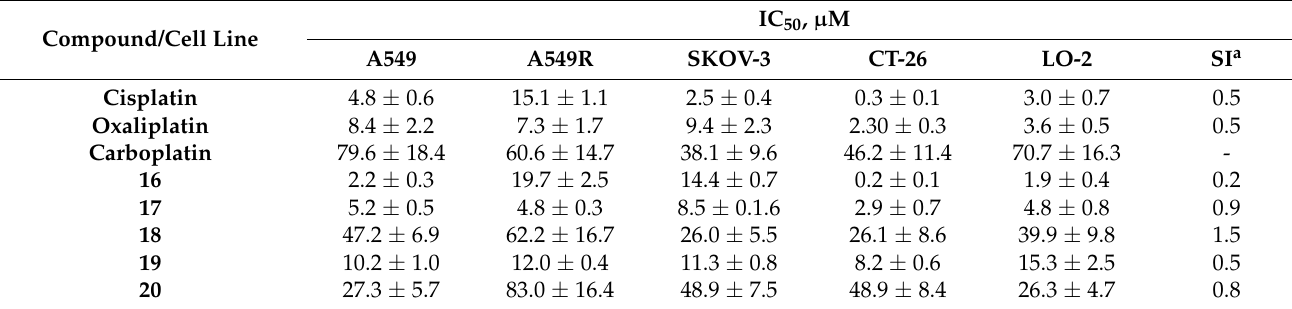
Table 9. Antiproliferative activity of cisplatin-, carboplatin-, oxaliplatin-based and platinum(IV) prodrugs 16–20 on A549, A549R (cisplatin-sensitive and cisplatin-resistant lung carcinoma, respectively), SKOV-3 (ovarian cancer), CT-26 (colon cancer), and LO-2 (human normal liver) cell lines. Selectivity index (SI) = IC 50 (LO-2)/average IC 50 values. Compound/Cell Line